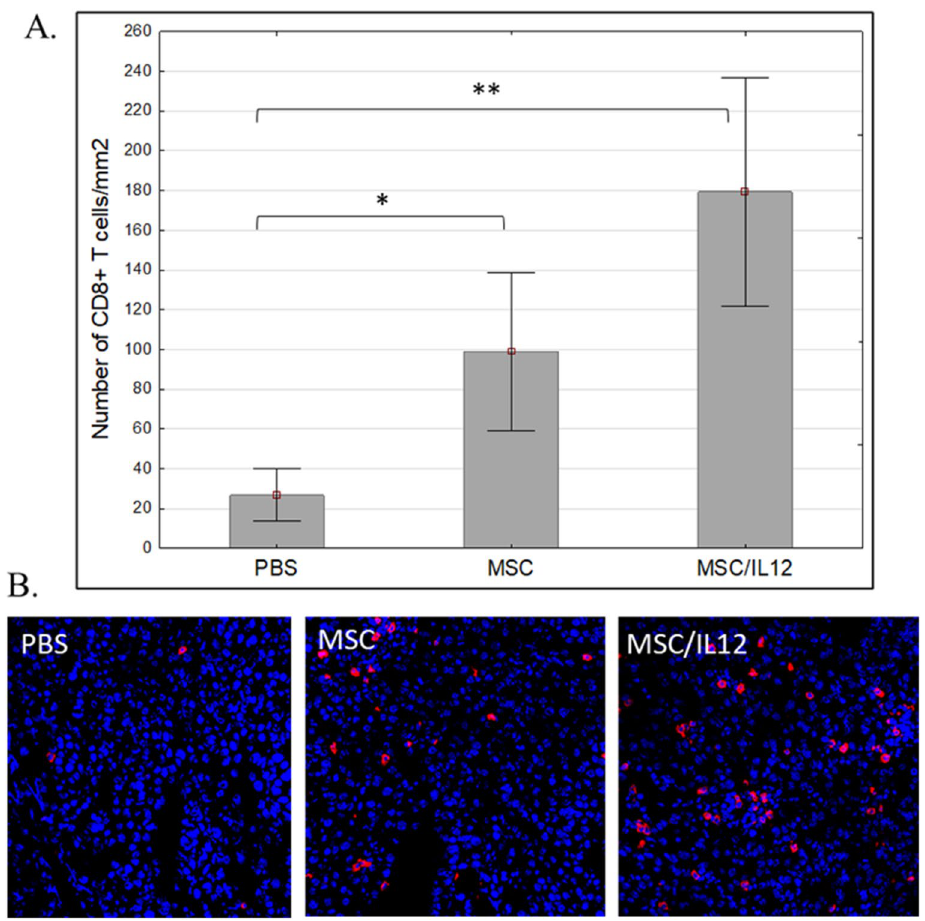
Figure 13. The effect of applied therapy on CD8 + lymphocytes in tumors excised 3 days after MSC/IL-12 administration. Total number of CD8 positive T cells was calculated per mm 2 of tumor section (n = 5). The number of CD8 + surface area T cells (per mm 2 of the preparation) in group that received MSC/IL-12 was over eightfold higher comparing to control and over fivefold higher compared to MSC group ( A ). Representative images of tumor sections from mice treated with PBS, unmodified MSC or MSC/IL-12 ( B ). CD8 + T lymphocytes (AlexaFluor594—red), cell nuclei (DAPI—blue), lens magn. 20x, *p < 0.05, **p <